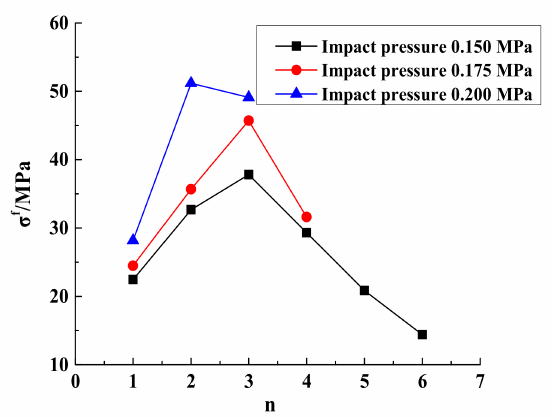
Figure 9. Peak stress vs. the number of cyclic impacts, for different impact pressures.